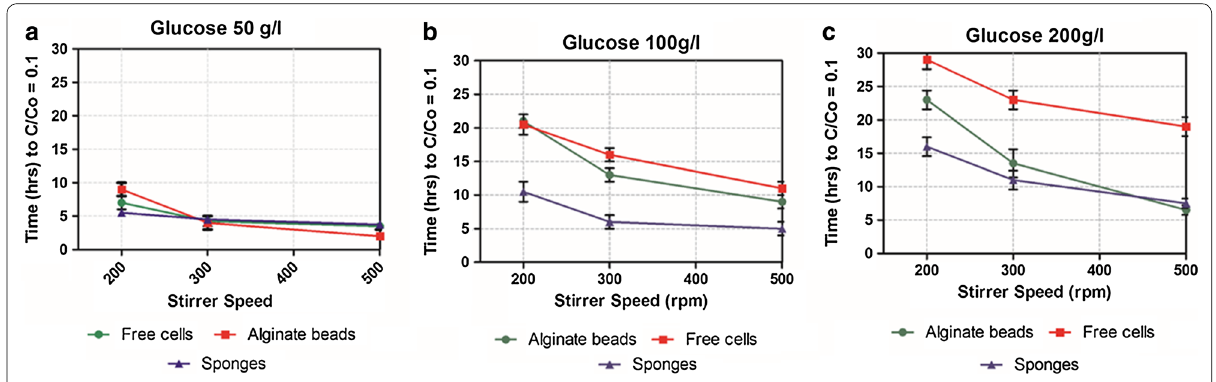
Fig. 3 Effect of agitation speed and immobilizing matrices on glucose consumption a at 50 g/l, b 100 g/l and c 200